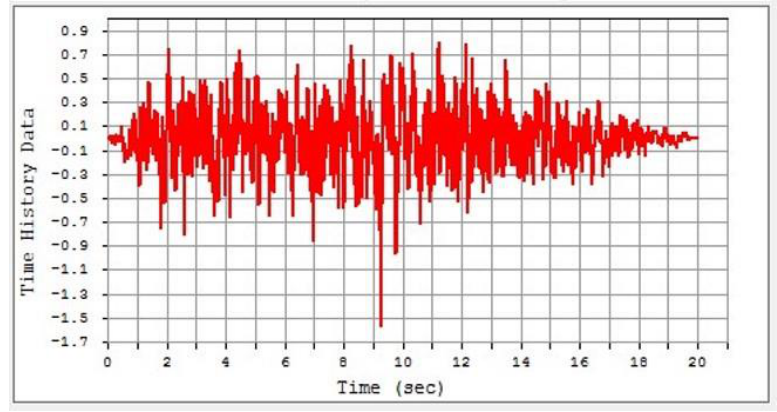
Figure 20. Time history data of acceleration in m/s 2 (accelerogram 1).